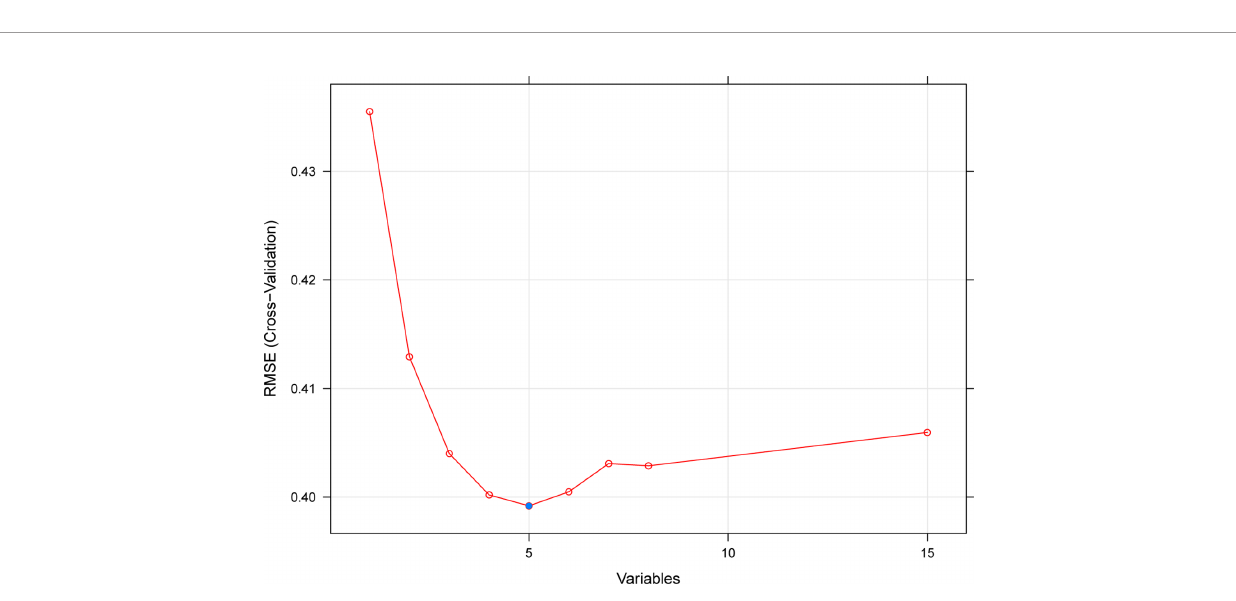
FIGURE 3 | A plot of feature immune-related gene selection by recursive feature elimination. The blue dot indicates the best fi ve